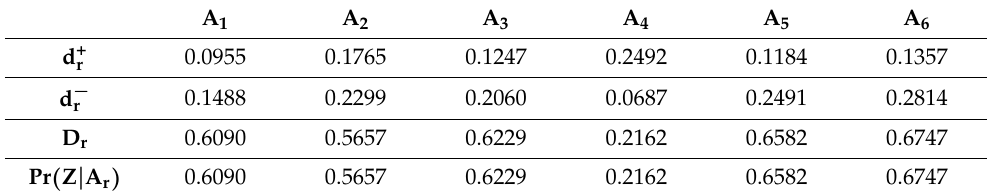
Table 6. The GRC, RRD, and conditional probability.